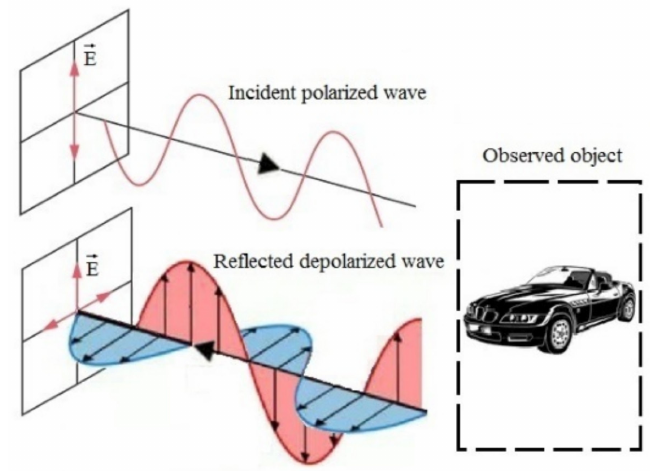
Figure 1. Principle of obtaining a polarized target signature. E—vector of electric-field